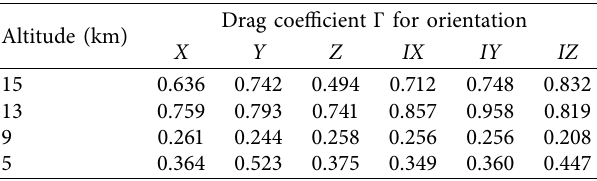
Table 2: Values of the drag coefficient Γ for individual orientation of the largest fragment of the Koˇsice meteorite (2370 g) in selected altitudes [14]. Altitude